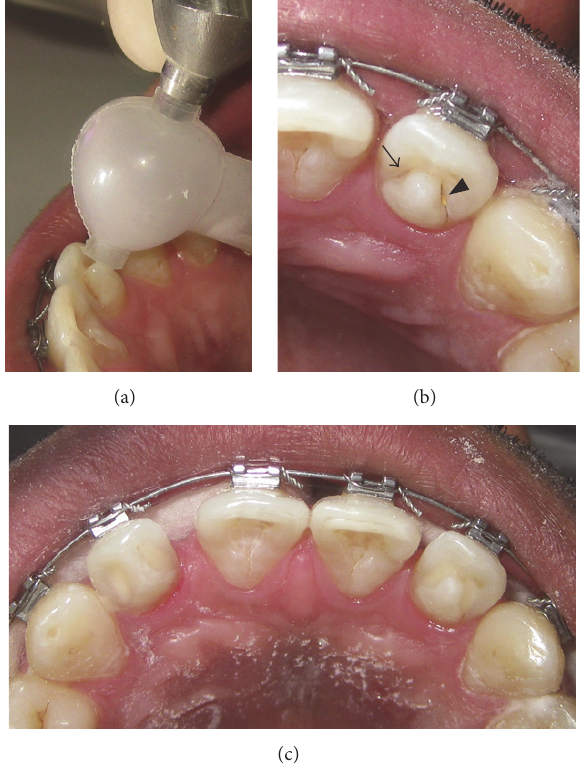
Figure 2: (a) Use of sand trap while using air abrasion; (b) prepared groove (long arrow) and unprepared groove (short arrow); (c) sealing of the grooves with